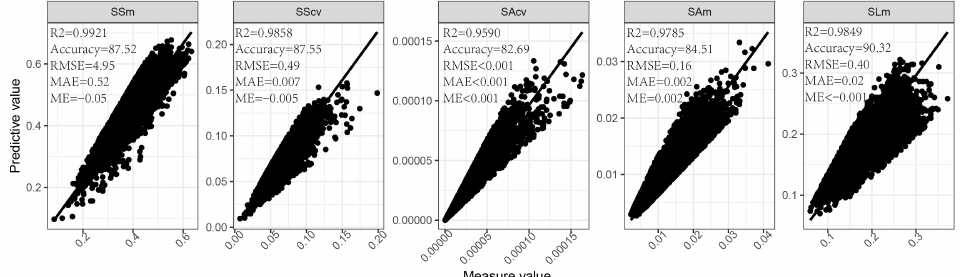
Figure 5Figure 5. The relationship between the model output and the manually measured data of seedling spacing and seedling size-related indicators. SSm: the average value of seedling spacing in the exper- imental plot; SScv: the coefficient of variation of seedling spacing in the experimental plot; SAm: the average value of seedling area in the experimental plot; SScv: the coefficient of variation of seedling area in the experimental plot; SLm: the average value of seedling spacing in the experimental plot.